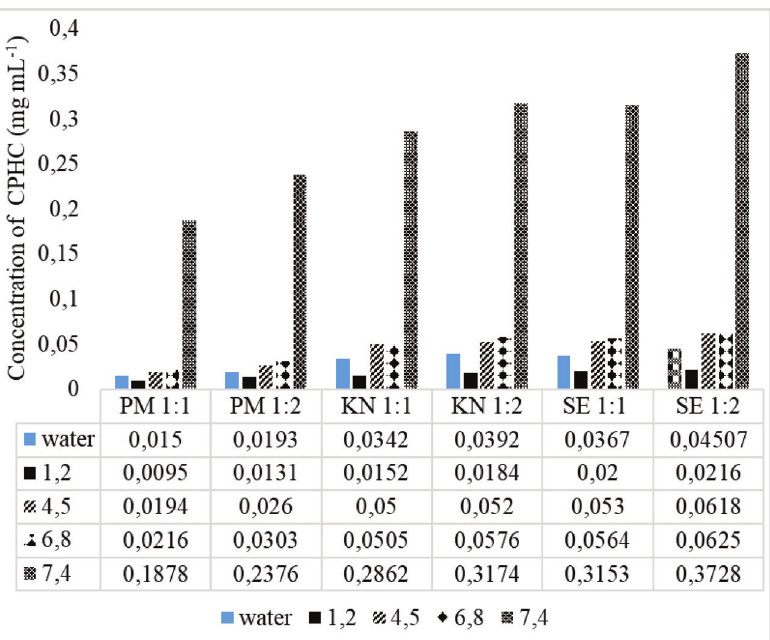
FIGURE 8 - Solubility of physical mixtures and inclusion complexes of 3-(3-(2-chlorophenyl)prop-2-enoyl)-4-hydroxycoumarin with 2- hydroxypropyl-β-cyclodextrin in purified water and aqueous buffer solutions at 37 o C ± 0.1 o